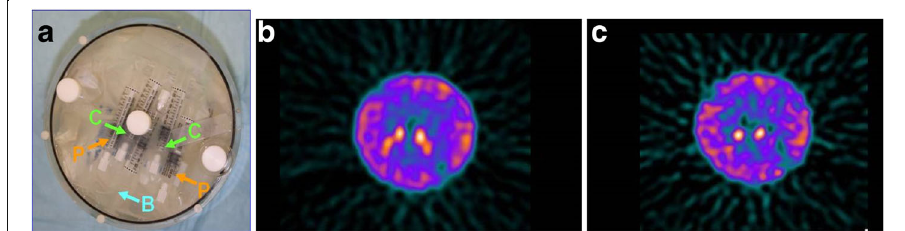
Fig. 2 Physical phantom. a Physical phantom with syringes loaded with radioactivity representing caudate (C) and putamen (P) structures, and radioactivity loaded into surrounding water background (B). Reconstructed phantom images for simulations representing ( b ) essential tremor and ( c ) Parkinson ’ s